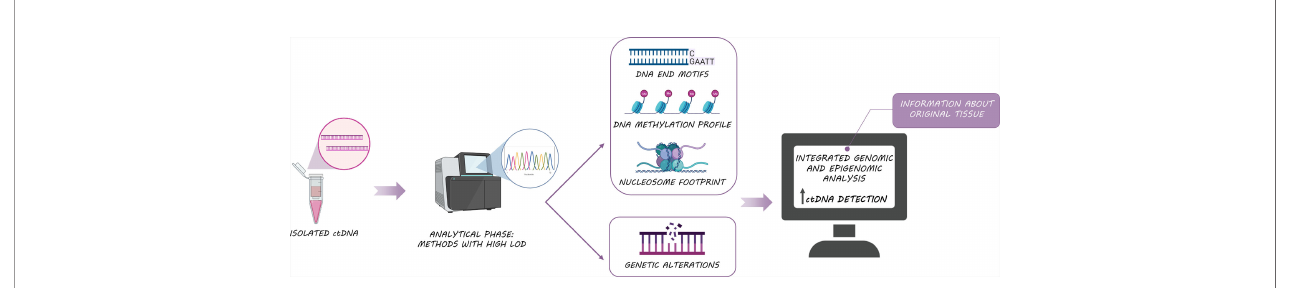
FIGURE 3 | Biological features of ctDNA: The integrated analysis of ctDNA somatic alterations, methylation and fragmentomic information, improves ctDNA detection and provides useful information about